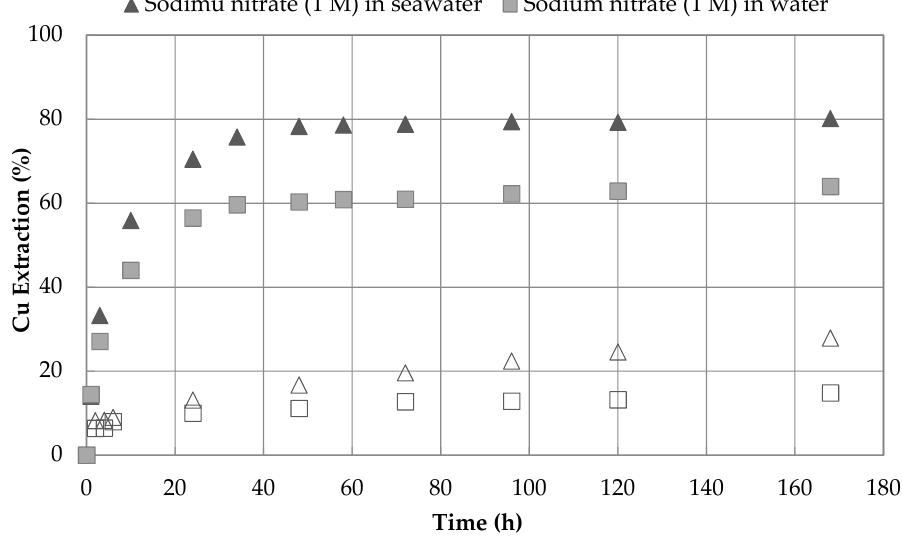
Figure 1. Copper extraction in the leach liquors using H 2 SO 4 (1 M) + NaNO 3 (0 or 1 M) in seawater and water based media (at 45 °C and 7 days).